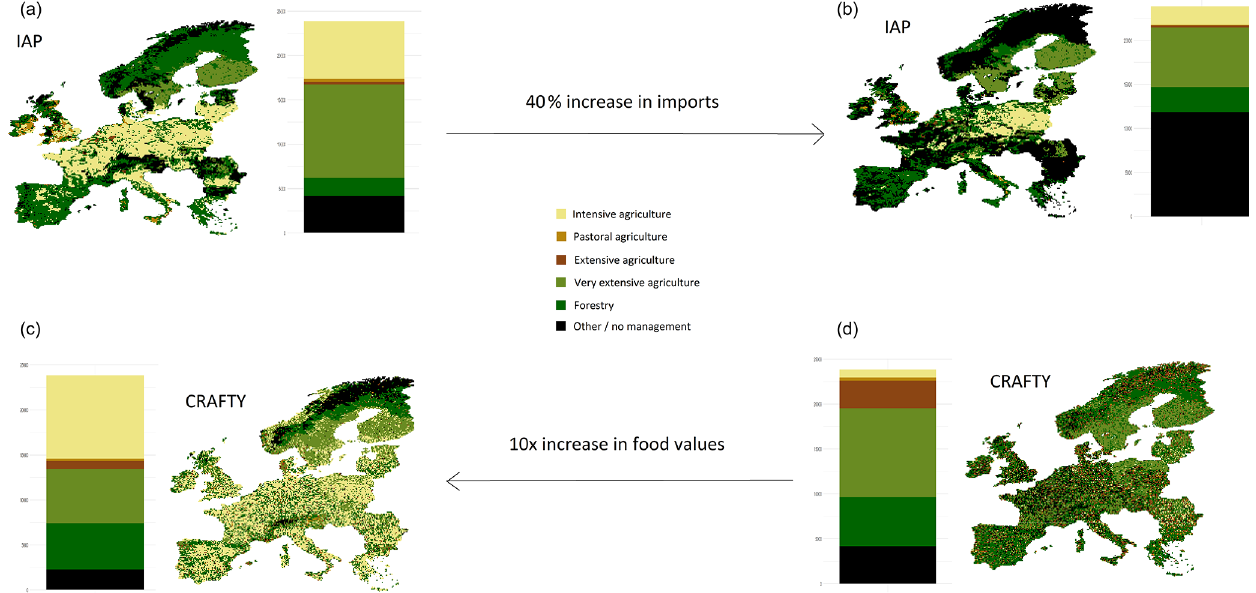
Figure 5. Cell-level and EU-level results for the RCP4.5–SSP3 scenario with and without alternative parameterisations designed to introduce analogous driving conditions to each model in turn. The IAP experiment is shown in (a, b) , and the CRAFTY experiment is at the bottom. The original IAP result (a) moves towards the original CRAFTY result (d) with a 40% increase in imports allowing less production of food within Europe, resulting in widespread land abandonment in the new IAP result (b) . The original CRAFTY result (bottom right) moves towards the original IAP result (a) with a 10-fold increase in food prices used to stimulate production, resulting in far more intensive agriculture in the new CRAFTY result (c) . In neither case do the new results reproduce the original